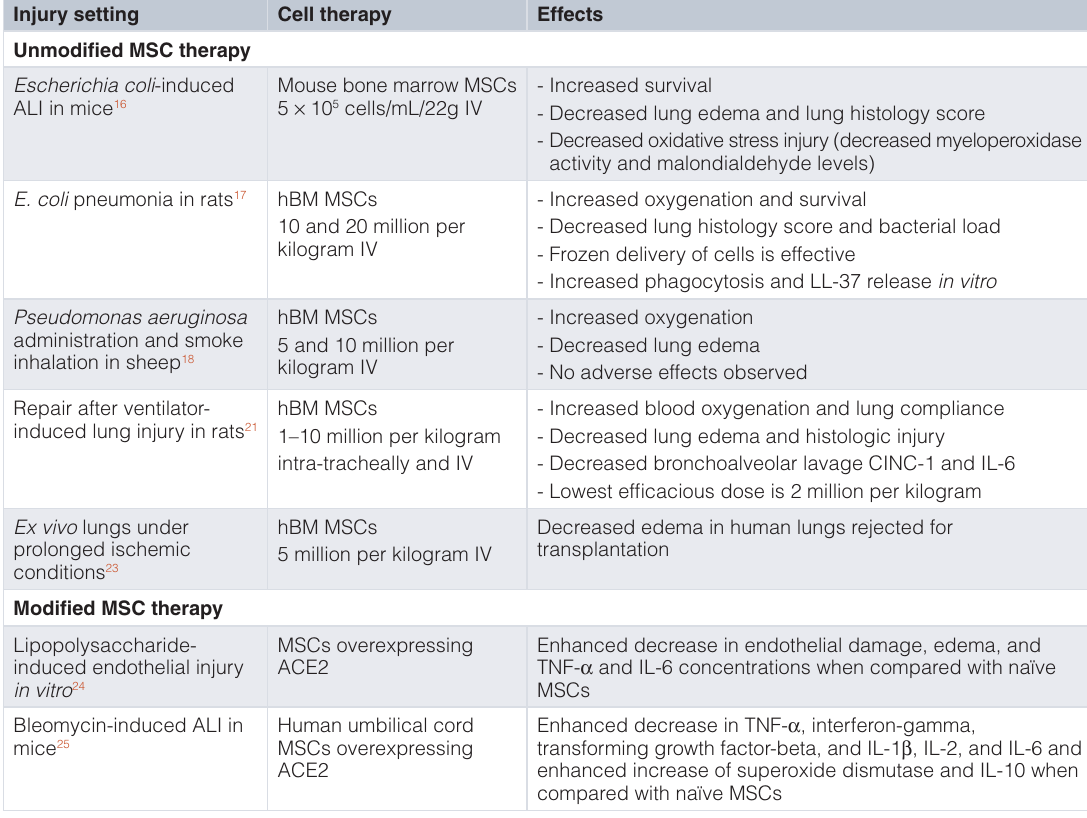
Table 1. Recent insights into mesenchymal stromal/stem cell efficacy in preclinical models. Injury